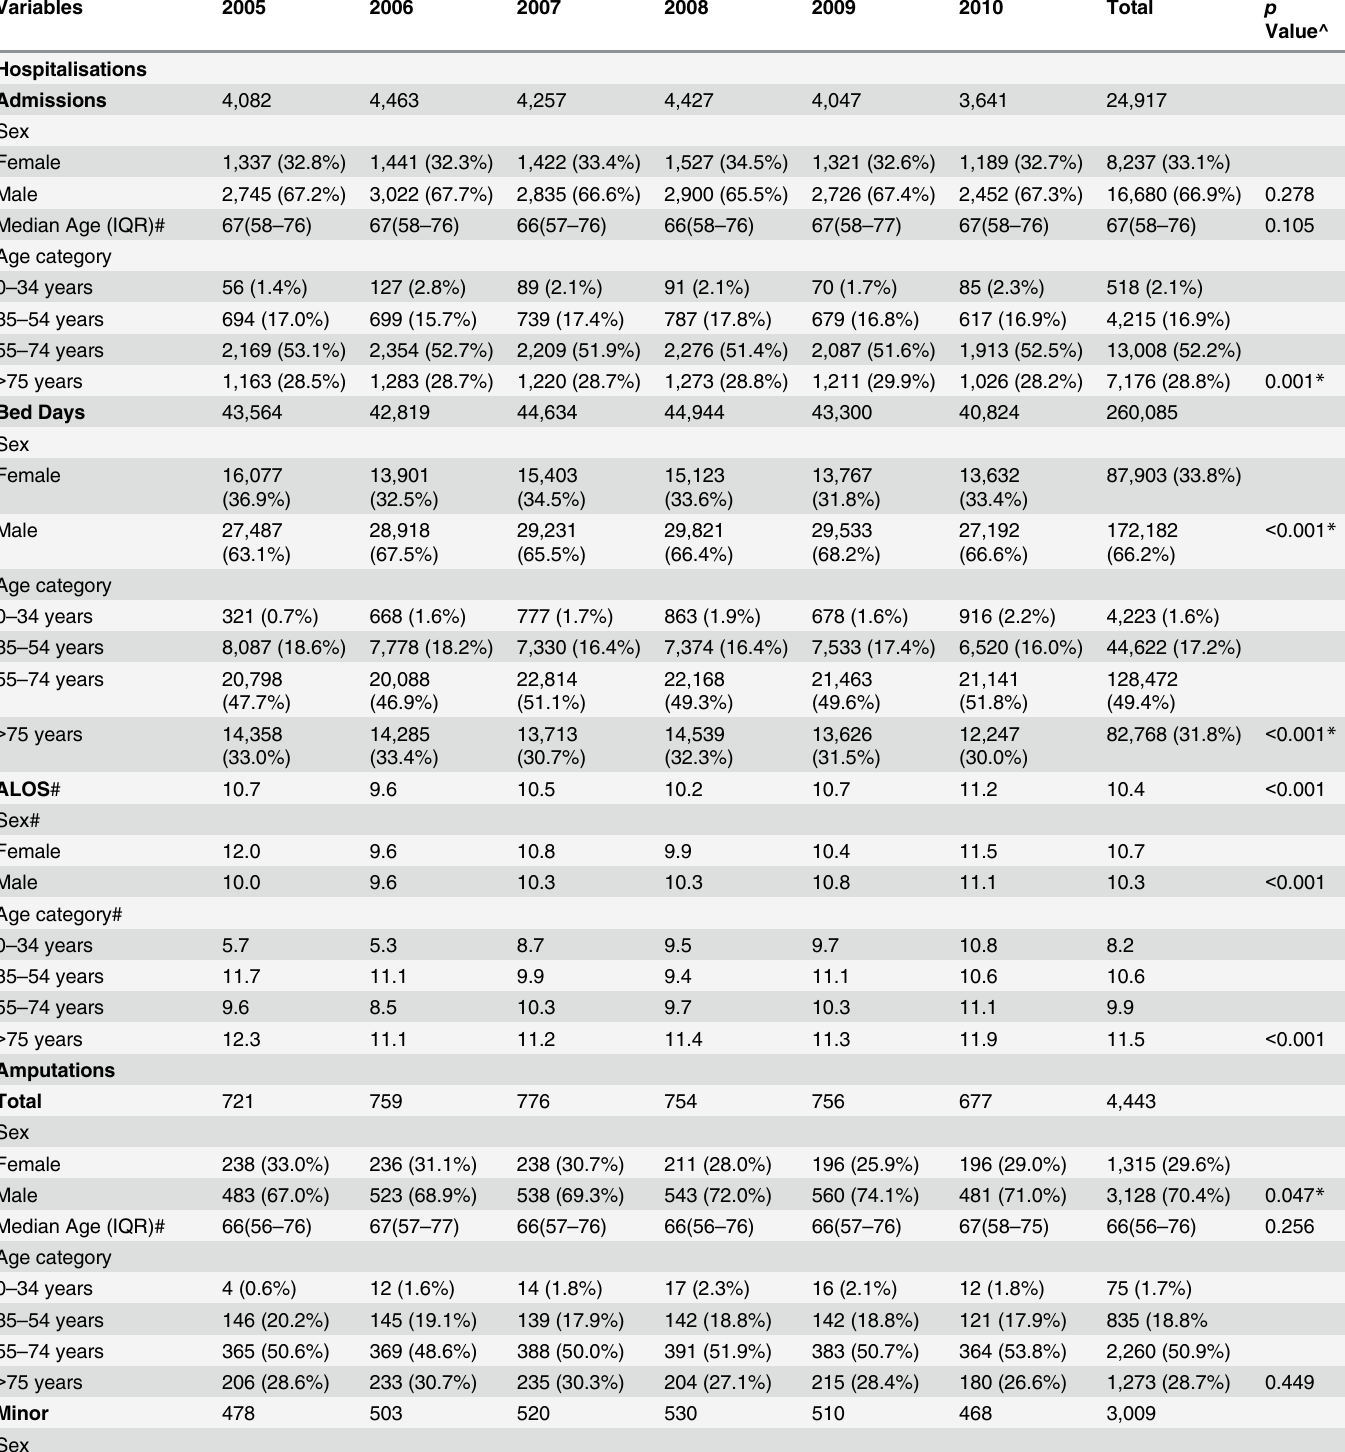
Table 2. Absolute numbers of foot-related hospitalisation (admissions, bed days and average length of stay (ALOS)) and amputation (total, minor and major) cases amongst persons with diabetes, plus, estimated diabetes and general resident population, in Queensland from 2005 to 2010.